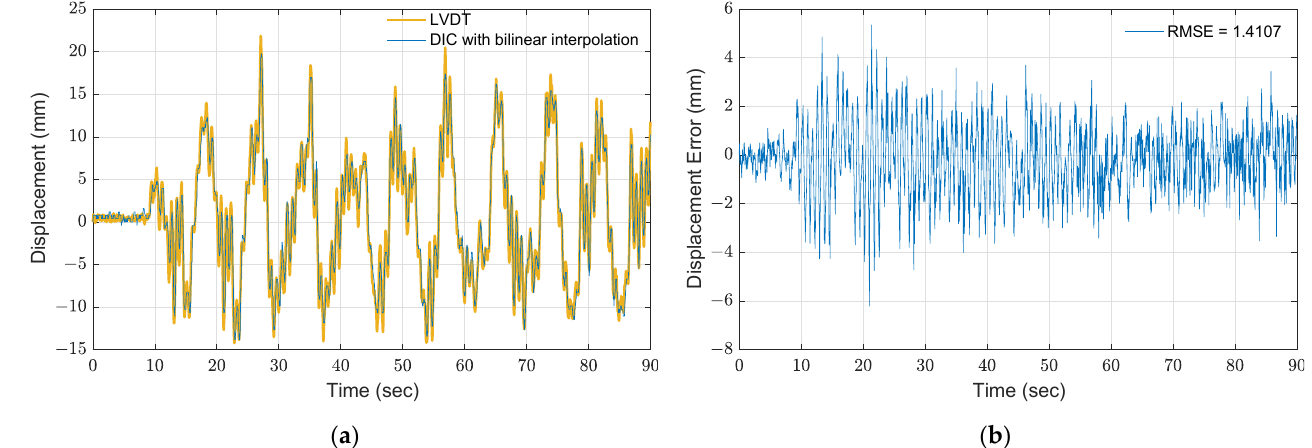
Figure 6. Results of DIC with bilinear interpolation: ( a ) comparison between the proposed method by a 20-subpixel inter- polation and LVDT measurement; ( b ) error.